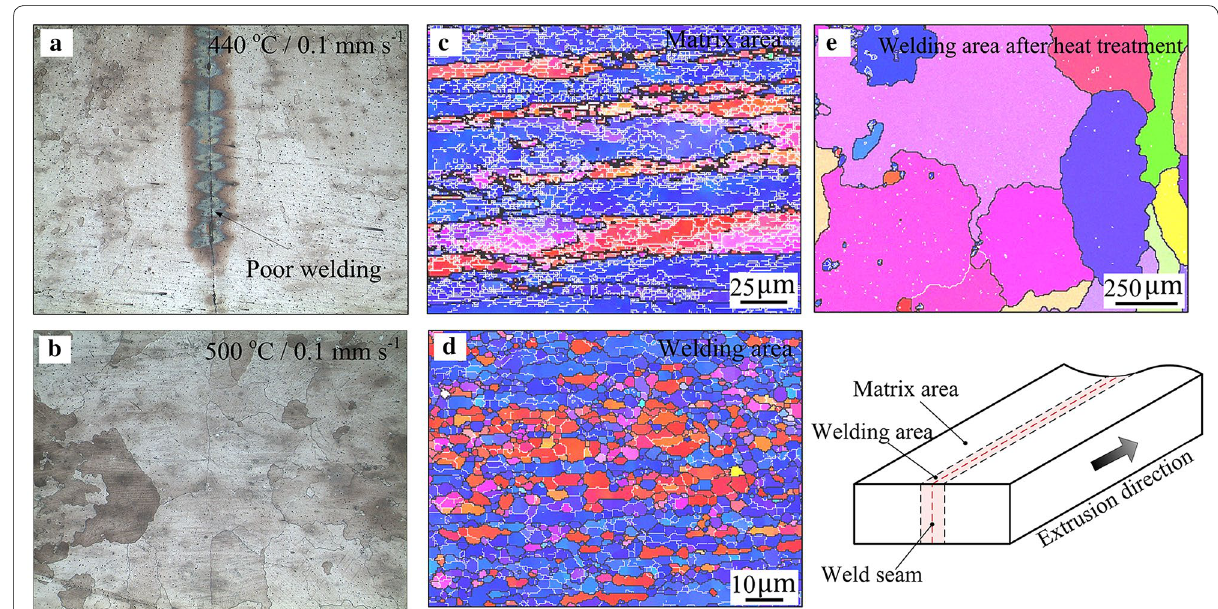
Figure 12 Microstructures of the extrusion welding interface of Al–Li alloy 2195: a , b The bonding degree of welding interfaces at different extrusion temperatures, c , d Grain structure of the matrix and welding area, e Grain structure of welding area after heat treatment (Reproduced from Ref.